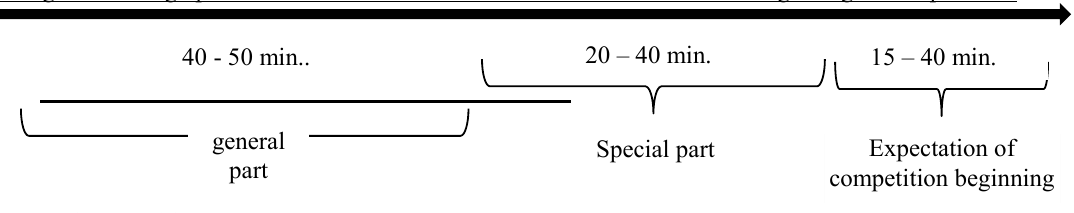
Fig. 1. Specificities of fencers’ pre-start warming